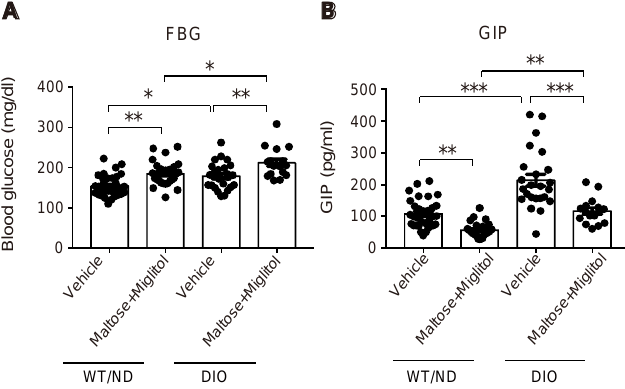
Figure 5. Blood glucose and plasma GIP levels in the portal vein after maltose + miglitol administration. A , B : Levels of blood glucose ( A ) and plasma GIP ( B ) in the portal vein at 30 min after oral administration of maltose + miglitol or vehicle to DIO and WT/ND mice ( n = 16–34 for each group). The data of the control mice are the same as those published previously by Lee et al. [12] and are presented for comparison with those of DIO mice. Bars depict mean ± SEM. * p < 0.05, ** p < 0.01, *** p < 0.001.